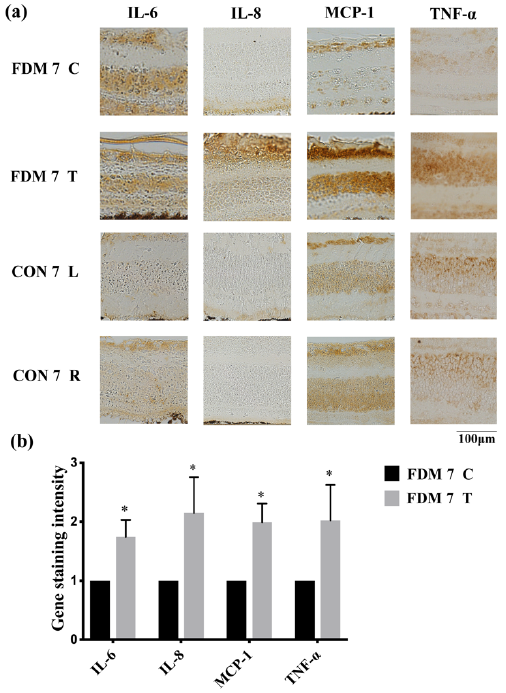
Figure 2. Expression levels of proinflammatory transcription factors and cytokines in the FDM and control eyes: ( a ) immunohistochemical analysis of IL-6, IL-8, MCP-1, and TNF- α expression at day 7 in the FDM and control groups; ( b ) gene staining intensity of IL-6, IL-8, MCP-1, and TNF- α determined using ImageJ software. * p < 0.05 (paired t -tests). ns, not significant; T, treated eye; C, contralateral control eye; L, left eye; R, right eye.